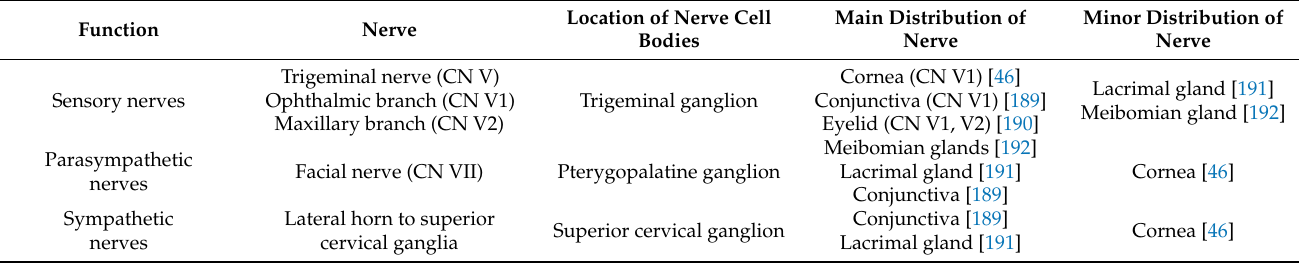
Figure 1. Schematic drawing for innervation of the lacrimal functional unit ALG: accessory lacrimal glands, CG: ciliary ganglion, CN: cranial nerve, FN: frontal nerve, GG: geniculate ganglion, ICA: internal carotid artery, LCN: long ciliary nerve, LG: lacrimal gland, LN: lacrimal nerve, MG: Meibomian gland, NN: nasociliary nerve, SCG: superior cervical ganglion, SCN: short ciliary nerve, SSN: superior salivatory nucleus, PPG: pterygopalatine (sphenopalatine) ganglion, TG: trigeminal ganglion (modified from Netter, FH, The Ciba Collection of Medical Illustrations, CIBA-Geigy Corporation, 1991). Table 1. Innervation of the organs related to dry eye